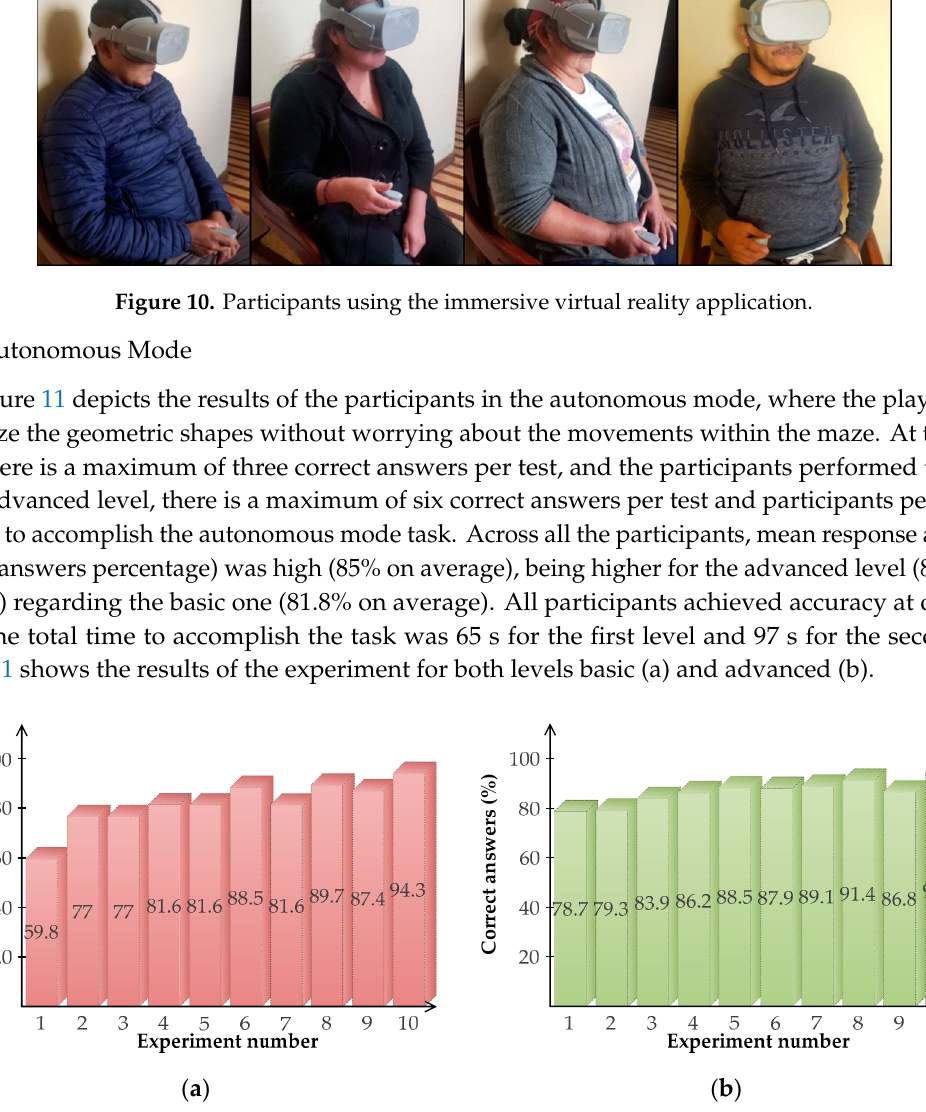
Figure 11. Results of the immersive virtual reality application in the autonomous game mode: ( a ) Success at the basic level; ( b ) Success at the advanced level.